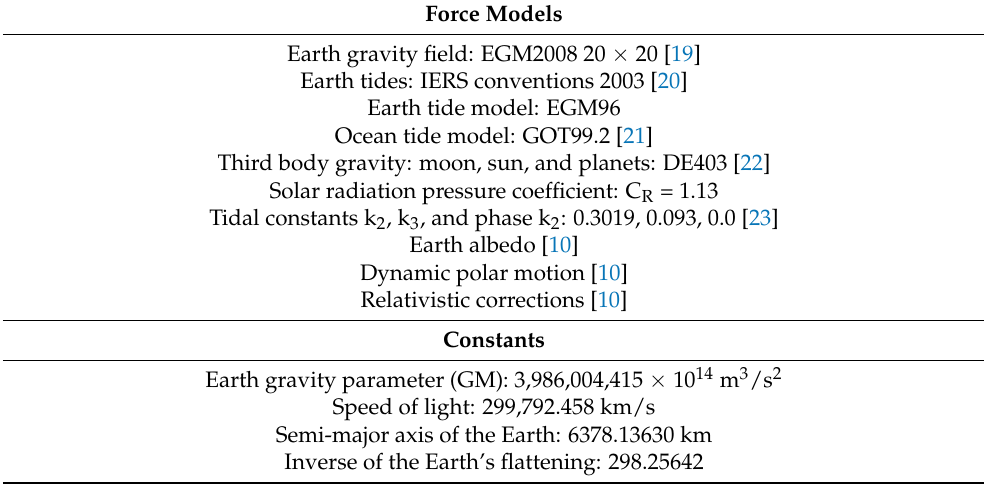
Table 3. Force models and parameters for the GEODYN-II orbital software—LAGEOS